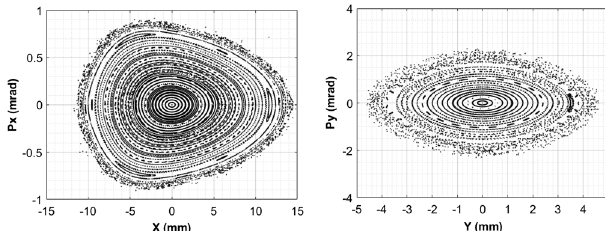
FIG. 17. Horizontal (left) and vertical (right) phase trajectories up to the last stable particle from Fig. 16 (rf is